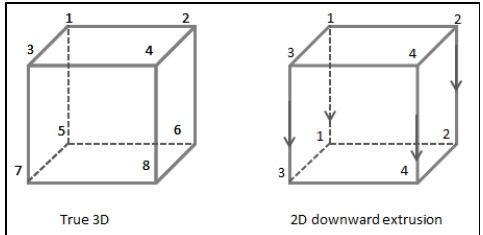
Figure 5: True 3D versus 2D extrusion